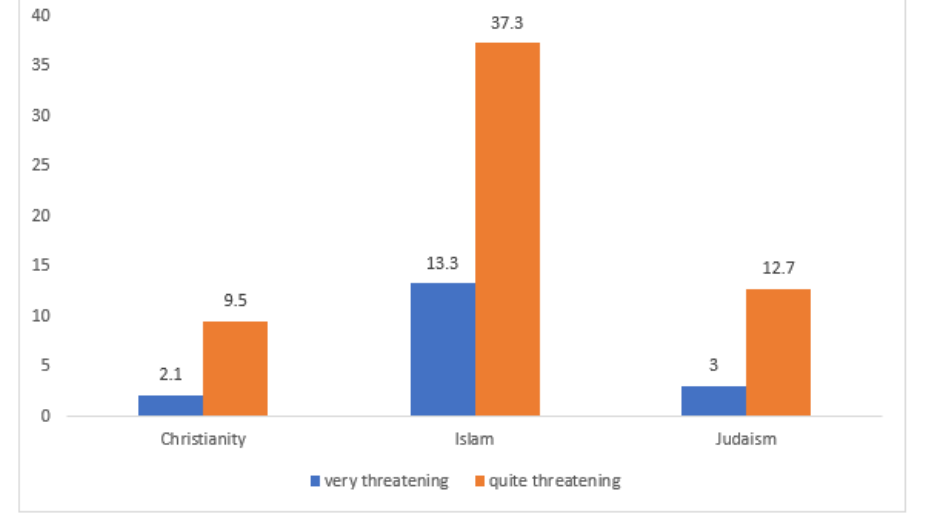
Figure 2. Source: XENO (2018); only non-Muslim respondents, own calculations,.